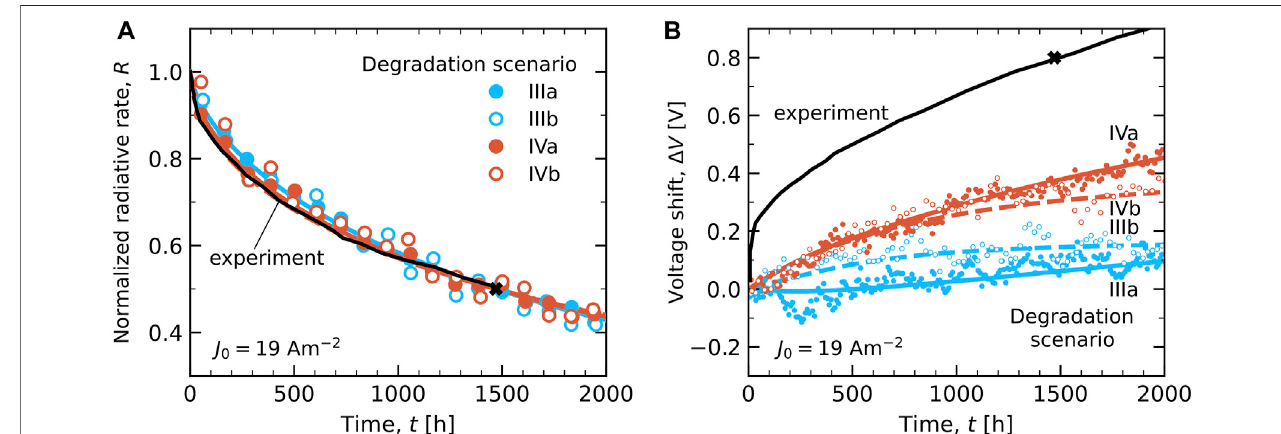
FIGURE 9 | Comparison of the experimental (black curves) and simulation results (symbols) at the same current density J 0 (cid:2) 19 Am − 2 for degradation scenarios III(a,b)andIV(a,b).Fullsymbols,andcurvesasguides-to-the-eye,areusedforscenariosIIIaandIVa,andhollowsymbols,withdashedcurves,areusedforscenariosIIIb andIVb.TheblackcrossgivestheexperimentalLT50lifetime(1,470 h). (A) Simulatedradiativedecayrate R ( t ),normalizedtotheequilibratedvalueinthepristinestate( t (cid:2) 0). (B) Voltage shift Δ V with respect to the equilibrated pristine